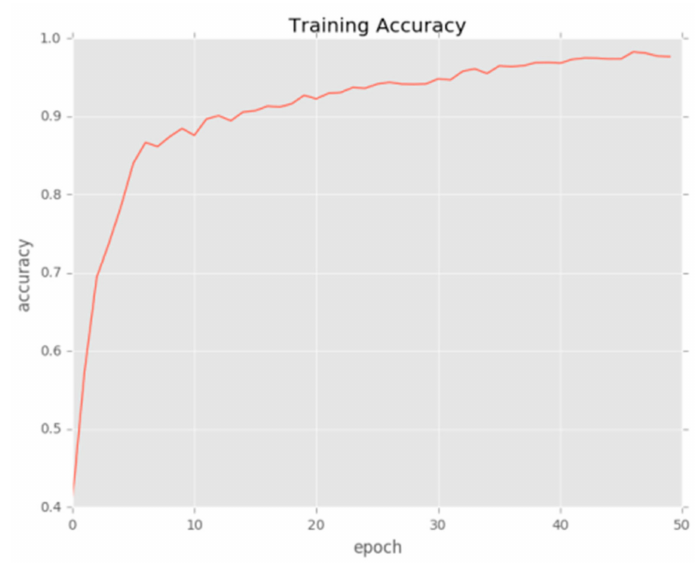
Figure 10. Train accuracy of the ST-CNN model.